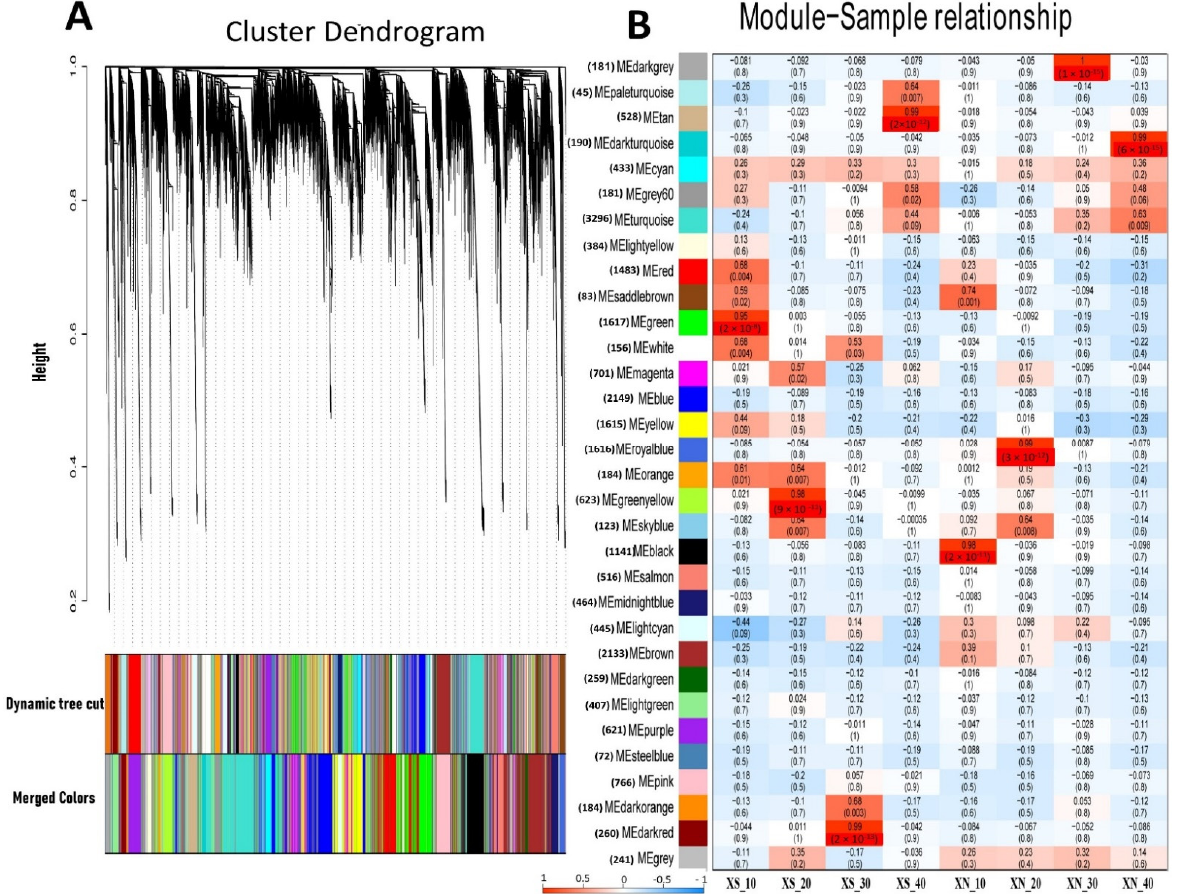
Figure 7. Establishment of WGCNA modules of the differentially expressed genes (DEGs) at the four stages of XIS (SWCC8)cucumber fruit development under short (XS) and day neutral (XN) photoperiod conditions. ( A ) Dendrogram of 21,742 DEGs obtained via hierarchical clustering of topological overlapping dissimilarity. ( B ) Relationships between module eigengenes (ME; rows) and sample at four stages (columns). The number in parenthesis against each eigengene is the number of DEGs. The color legend at the left corner underneath indicates the strength and direction of the correlation. Numbers within figure B are the partial Pearson correlations and the corresponding p -values. The upper value in each cell represents the correlation coefficient, and the lower value represents the p